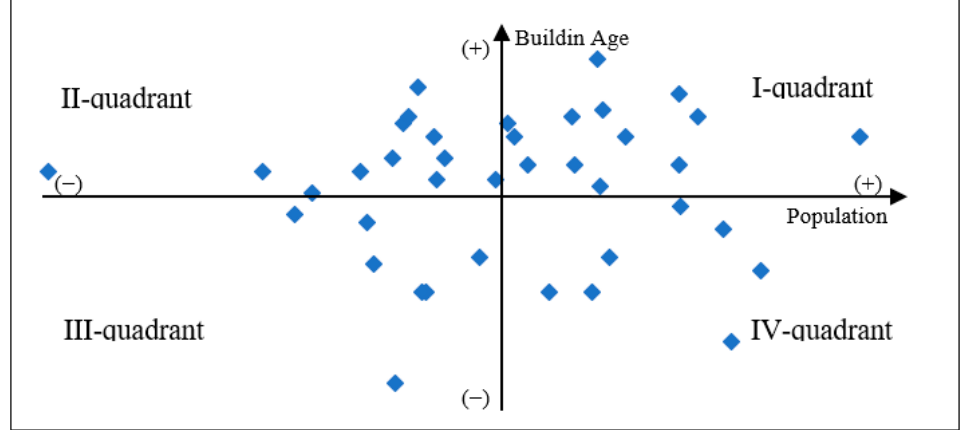
Figure 7. The 39 neighborhoods of Nei-Hu District: quadrant diagram.